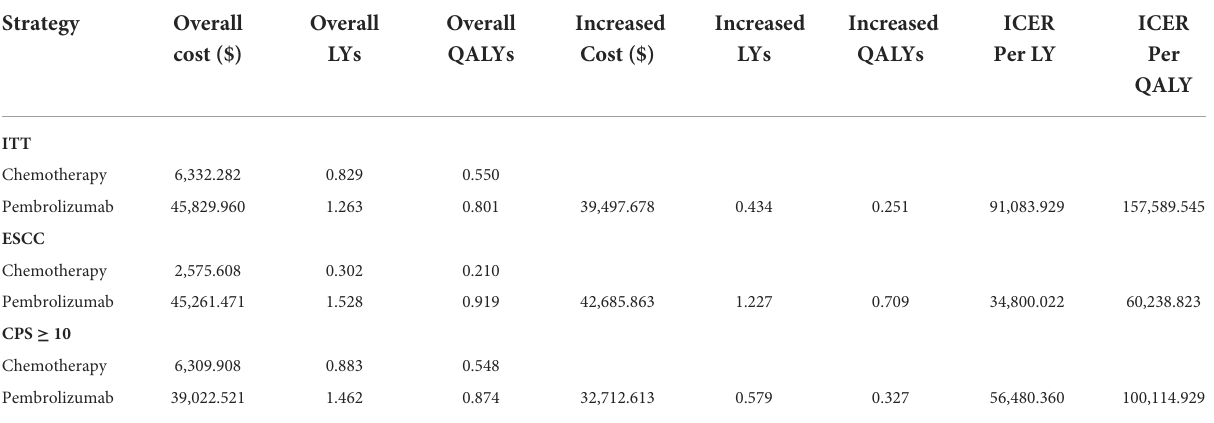
TABLE 3 Cost-effectiveness analysis